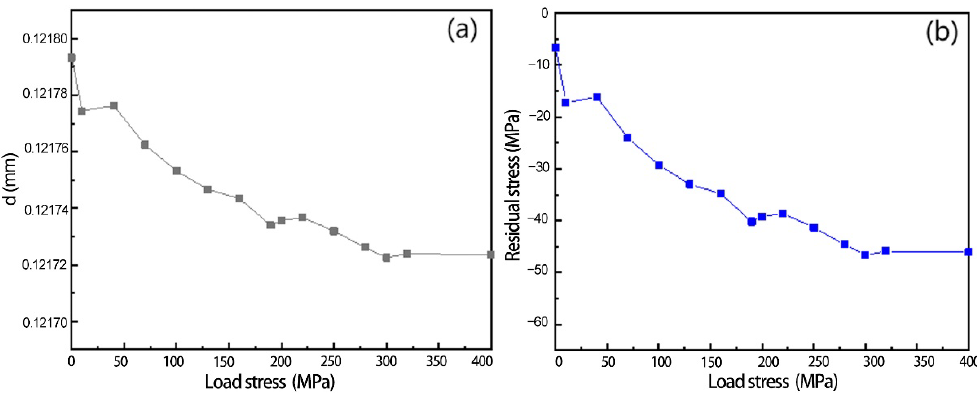
Figure 5. Variation of in situ loading process. ( a ) Crystal plane spacing; ( b ) residual stress.